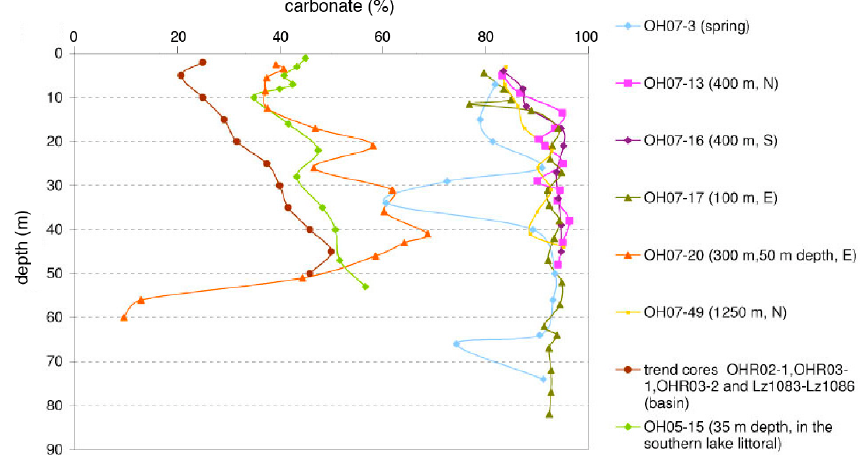
Fig. 9. Comparison of downcore profiles of carbonate % (as TIC values) of the littoral cores 03, 13, 16, 17, 20, 49 from this study with data from basinal cores (OHR02-1, OHR03-1, OHR03-2 and Lz1083 to Lz1086; Matzinger et al., 2006a) and of core OH05-15 recovered in 35m water depth in the southern littoral basin, at ∼ 1km distance from the shore. The two minima of core OH07-03 correspond to coarser sediment lithologies. Note the general trend of upcore decreasing carbonate values in most cores independent on their water depth.